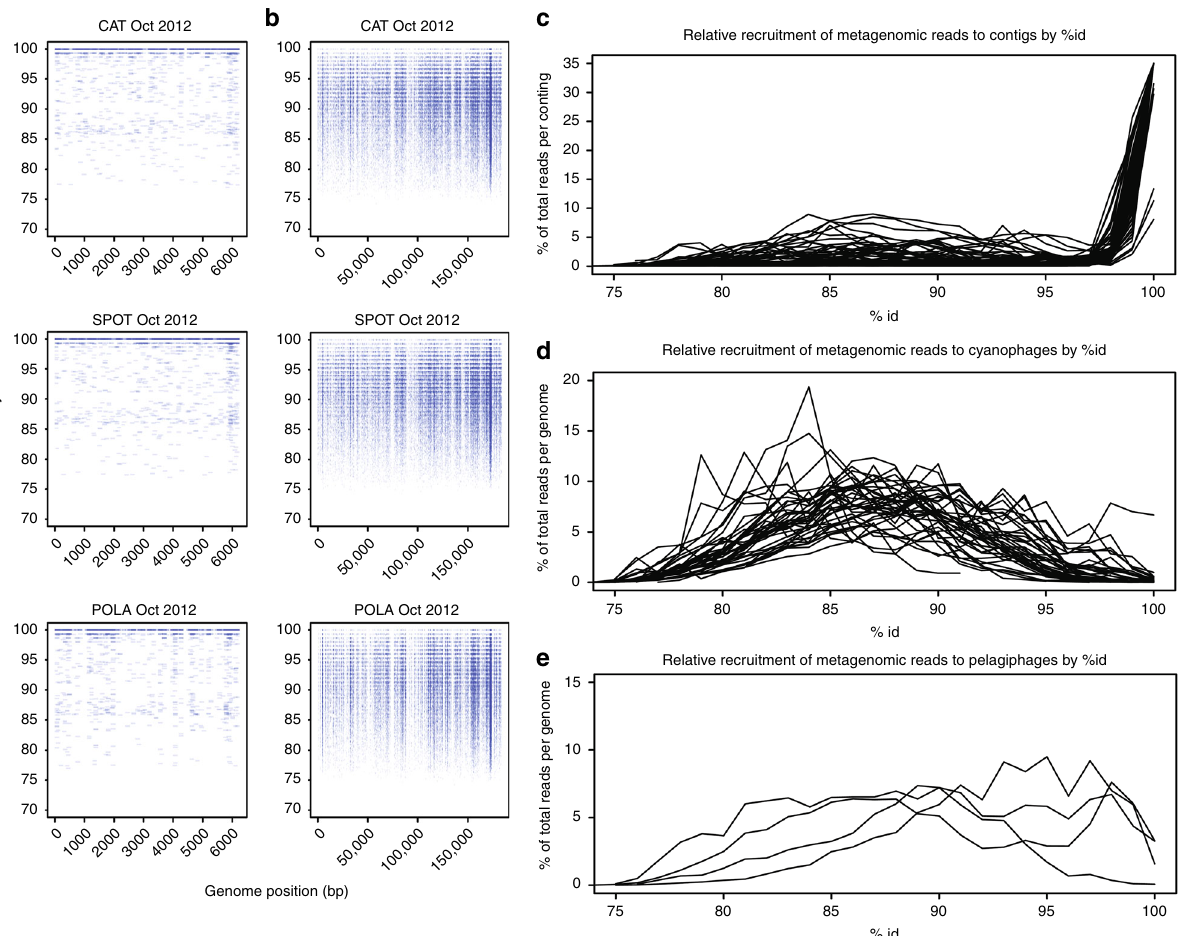
Fig. 2 Genomic diversity of assembled and curated phages. Metagenomic read recruitment (minimum 100 bp hit length) from October samples (single sample per site) to a an assembled cyanophage contig, and b Prochlorococcus phage P-HM2 genome. The highest recruitment to the assembled contig in a was at 99 – 100% identity (high density near 100% is not fully evident from the graph due to overlaps, see c ), whereas P-HM2 revealed a genomic continuum ranging from 80% to ~98% identity. c – e Recruitment as a function of percent identity of reads to assembled contigs ( c ), curated cyanophages ( d ) and curated pelagiphages ( e ) demonstrated that assembled contigs mostly recruited at 100% ID and had few moderately close relatives ( c )